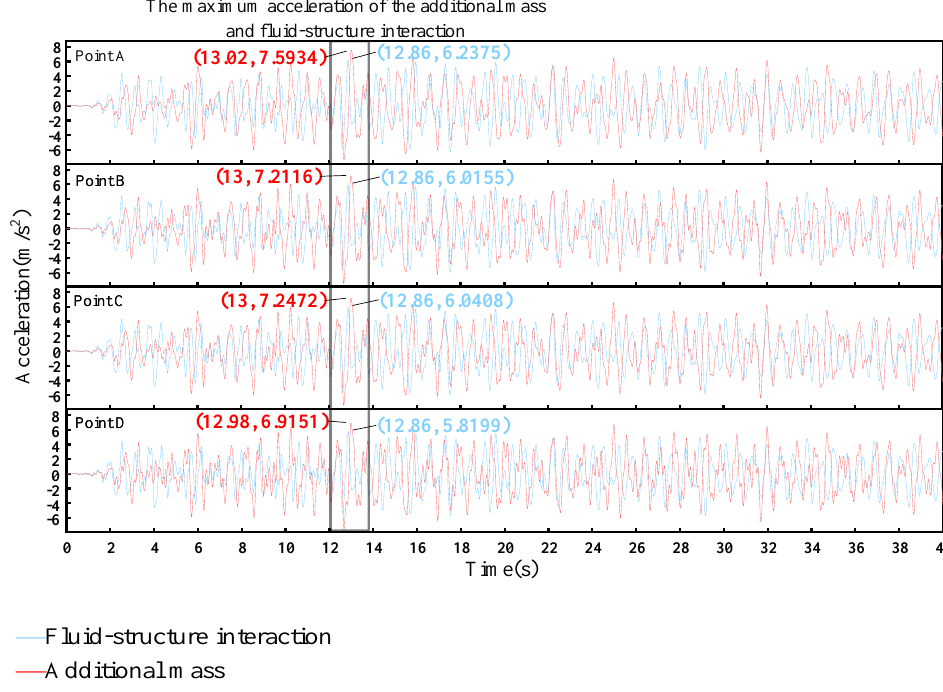
Figure 12. Acceleration response time history curve of the right platform pipeline cross-section.